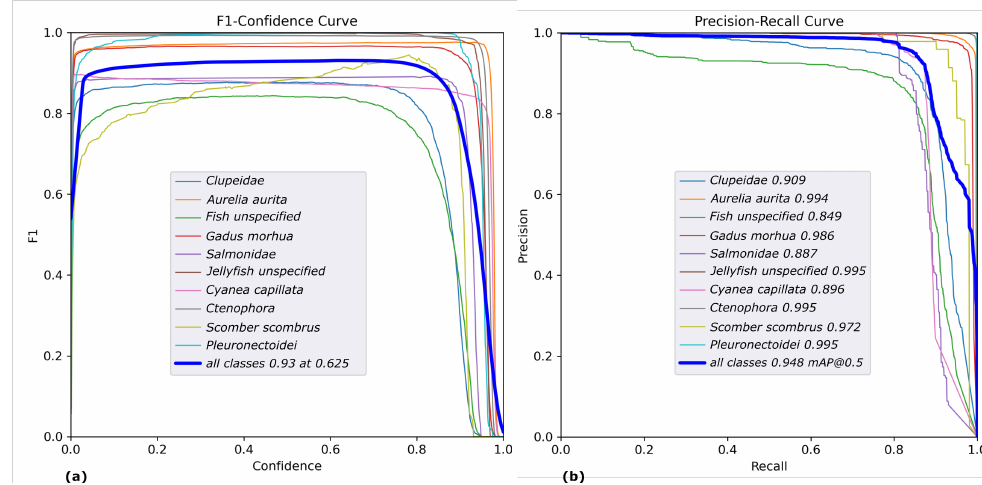
Figure 9. Plot of the class-wise F1 ( a ) and Precision-Recall ( b ) curves of the results obtained on validation data.